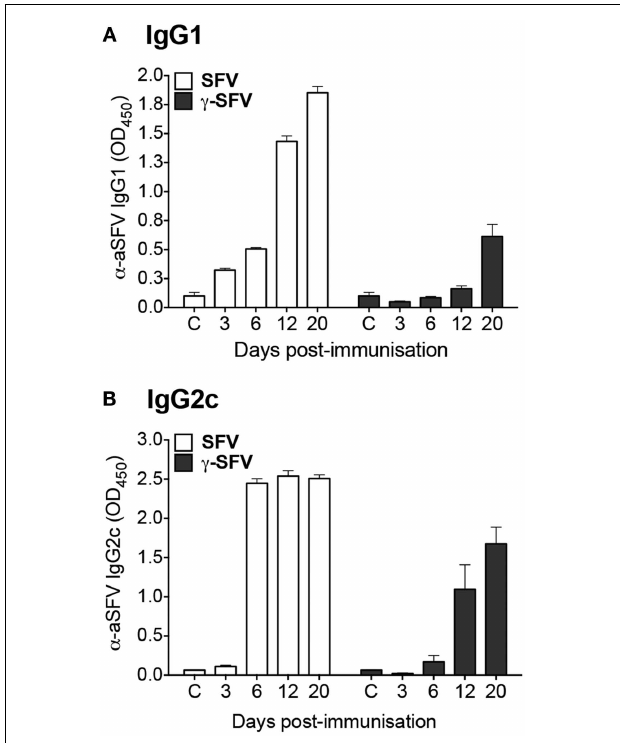
FIGURE 2 | Immunization with γ -SFV promotes lower antibody levels compared to SFV . Mice were injected i.v. with SFV (10 7 PFU) or γ -SFV (10 7 PFU equivalent/mouse). Serum SFV-specific IgG1 (A) and IgG2c (B) levels were measured at 3, 6, 12, and 20days post-immunization by direct ELISA at a serum dilution of 1/200. Sera from naive mice served as negative controls (c). Results are presented as mean ± SEM ( n = 3), ** p <